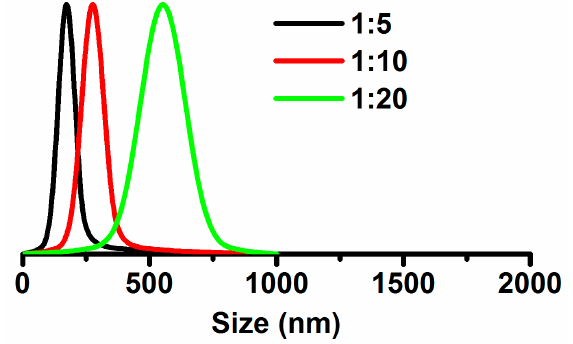
Figure 7. Size distributions of cSG-PAN prepared with different feed ratios of cSG to PAN.